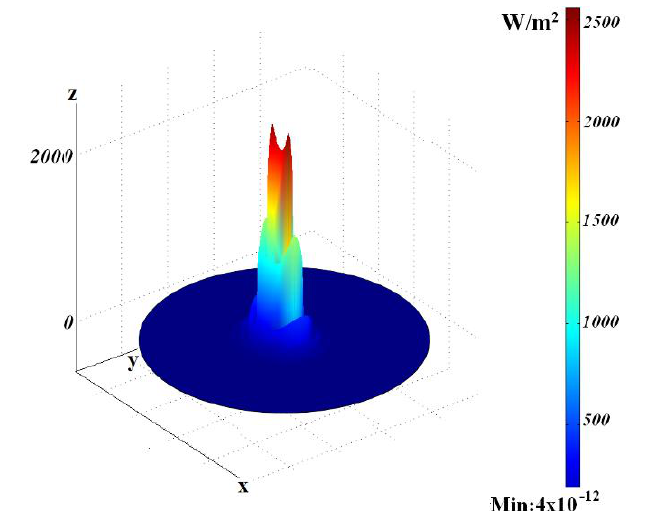
Figure 5. Three-dimensional power flow